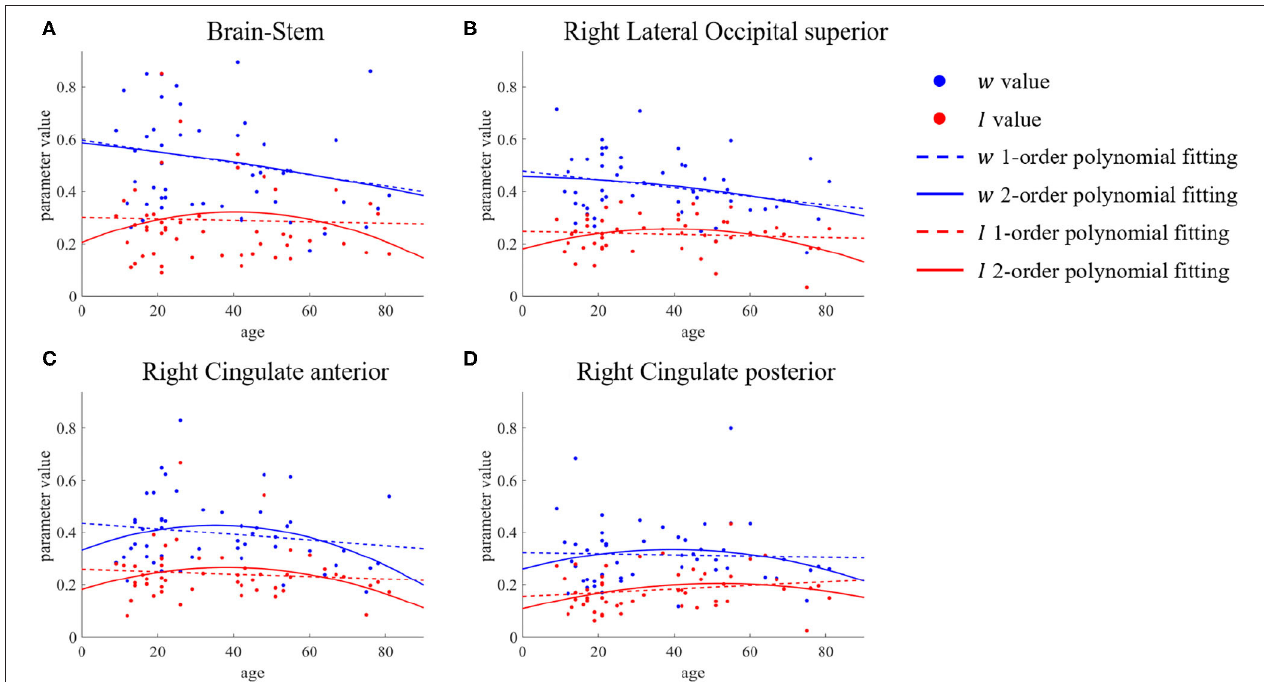
FIGURE 6 | ROIs with differences in first- and second-order polynomial fits of subcortical input strength I . The points represent the parameter values, the dashed lines are the first-order polynomial fits, and the solid lines are the second-order polynomial fits. Blue indicates w and red indicates I . (A) Brain-Stem. (B) Right Lateral Occipital superior. (C,D) Right Cingulate anterior & posterior.